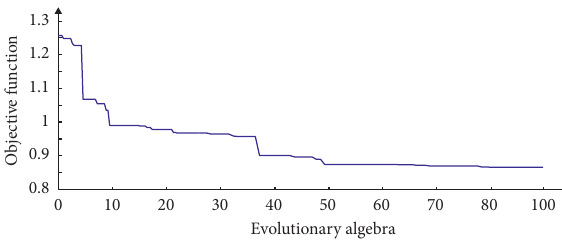
Figure 4: Change trend chart of objective function. Table 3: Comparison of powertrain parameters after